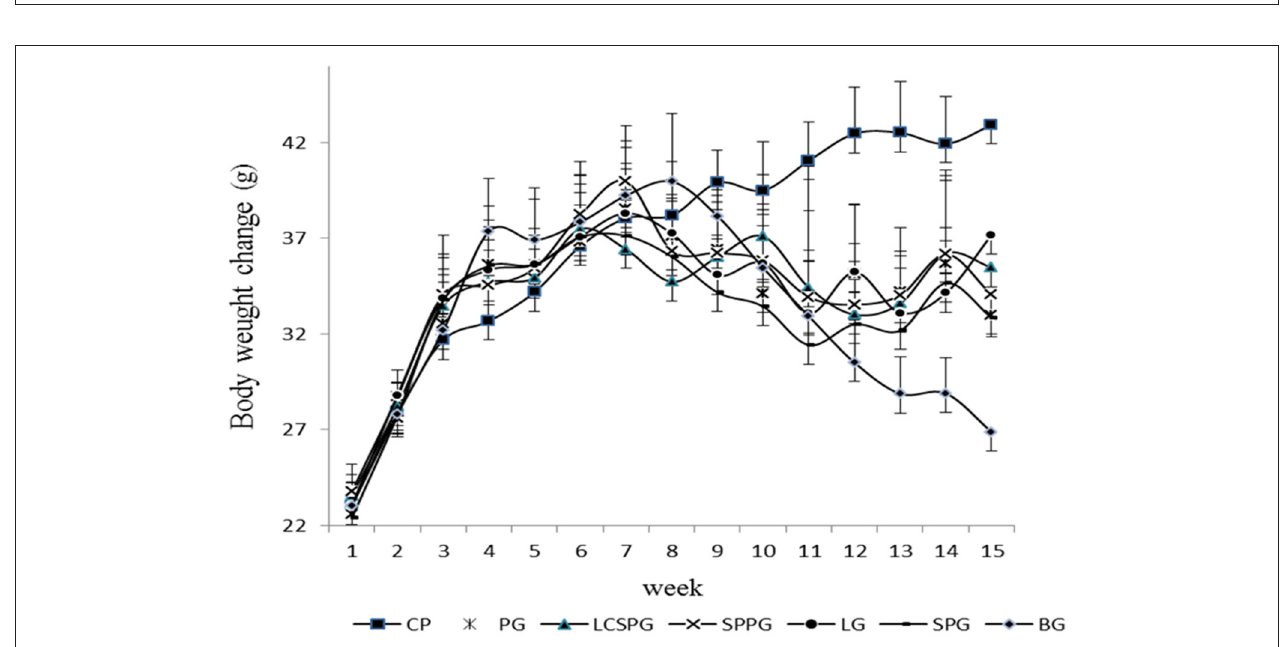
FIGURE 4 | Body weight change of mice when HFD, normal diet, and ON formula was given to corresponding groups for 15